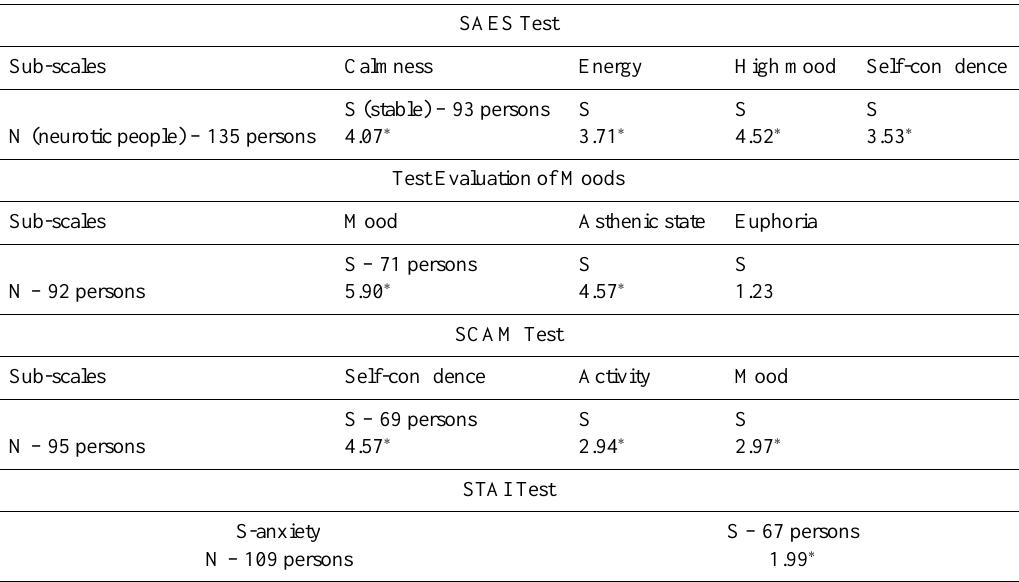
Table 3. Comparative analysis by t-quotient of the results of the used psychological methods for the impact of the weather on people with di ff erent neuroticism